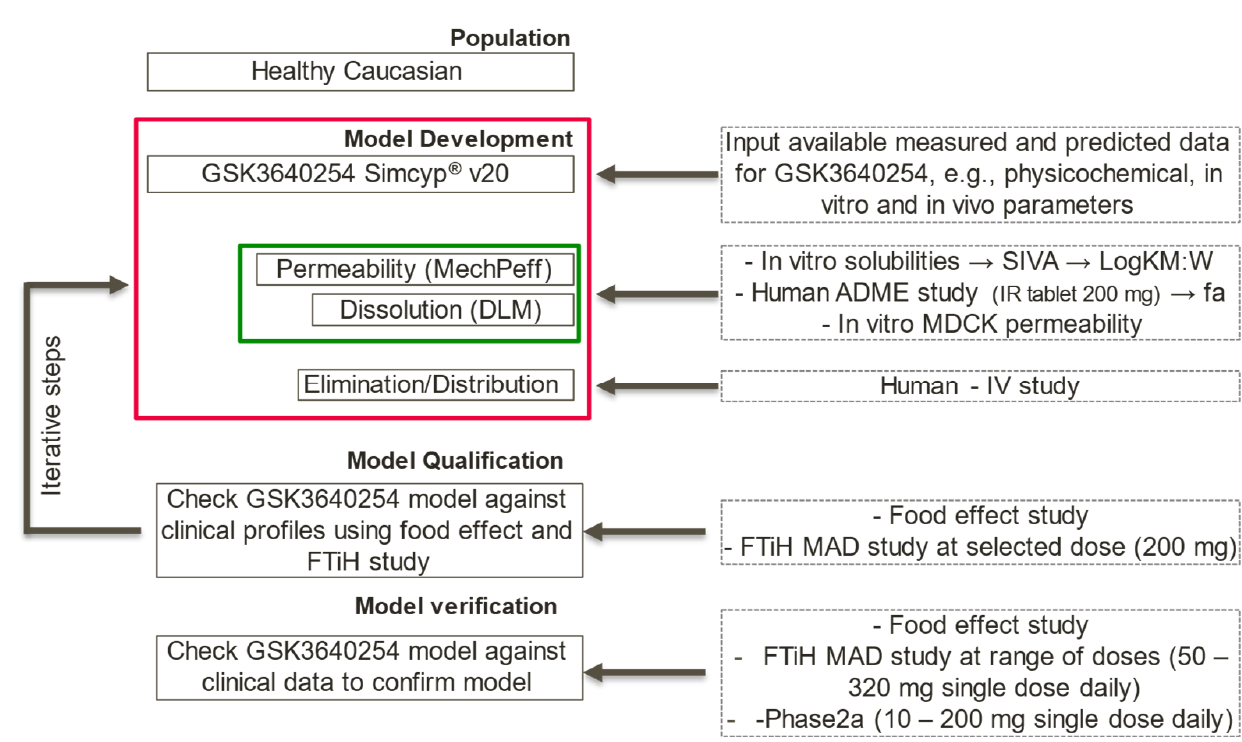
Figure 2. Workflow for PBPK model development, qualification and verification.